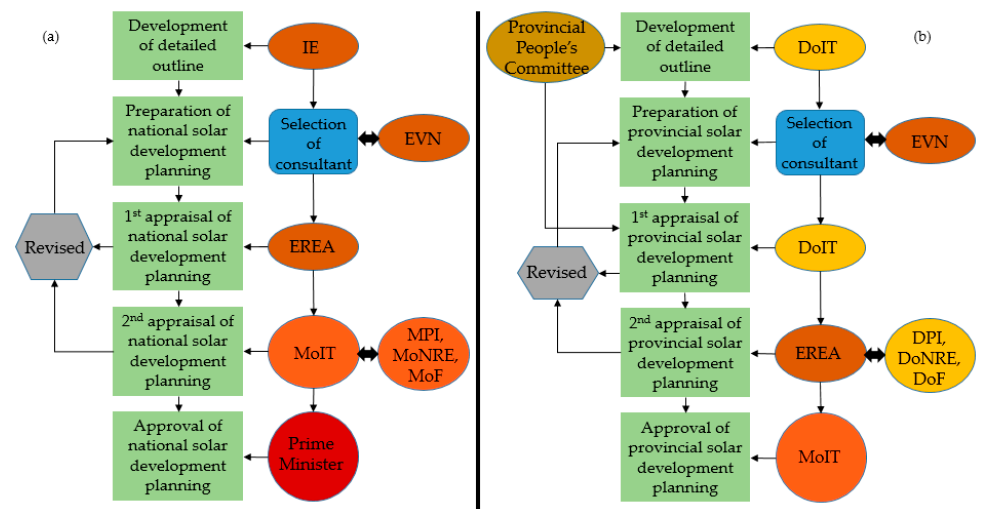
Figure 14. Procedures for formulation, submission, appraisal and approval of solar development planning at national ( a ) and provincial ( b ) level.